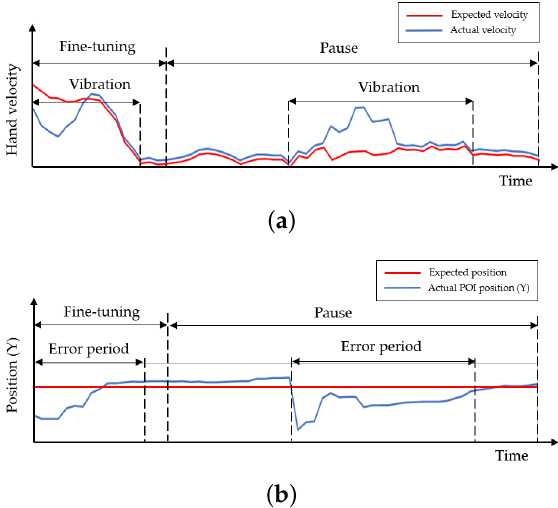
Figure 29. Error of straight index finger determination caused by vibration during hand pointing: ( a ) Index finger vibration, and ( b ) Index finger